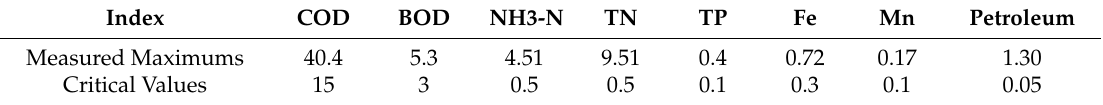
Table 5. Measured maximums during the 2011 water pumping period and the critical values of Class-II water in the Chinese Environmental Quality Standards for Surface Water